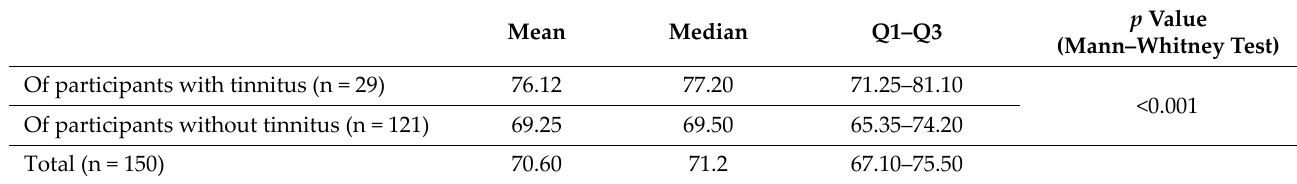
Table 3. Noise level (decibel measurement dBA) in the clinics.